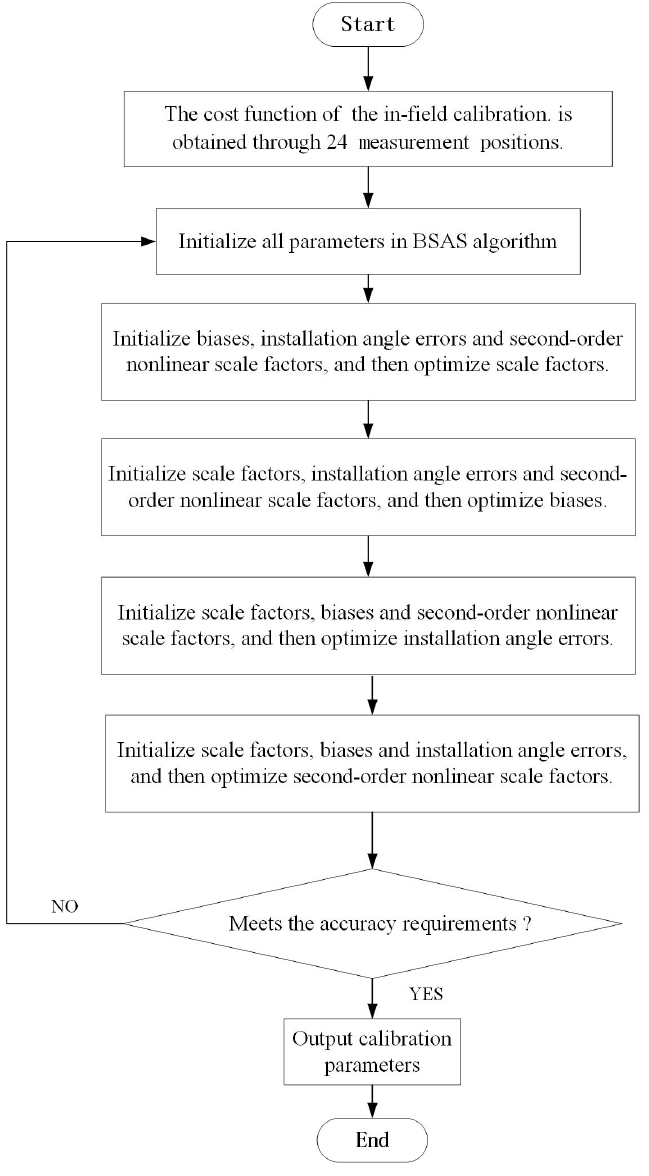
Figure 2. Flowchart of the proposed